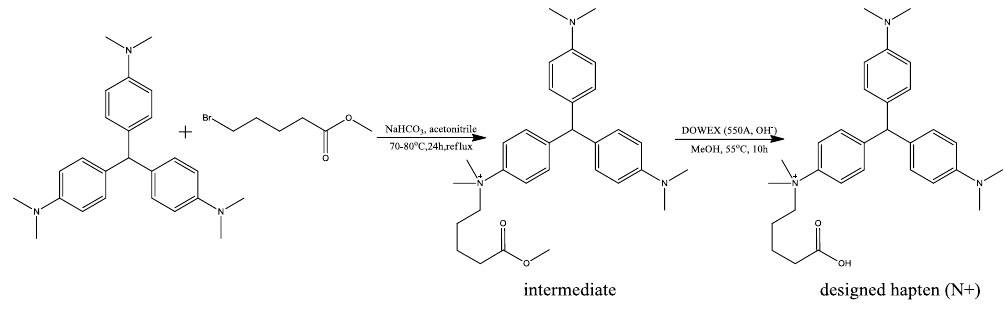
Figure 6. Synthesis protocol of the designed hapten (N+).